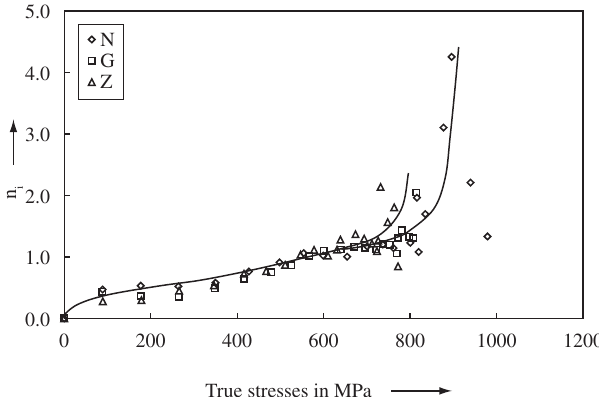
Figure 7. Relationship between instantaneous strain hardening exponent (n and true